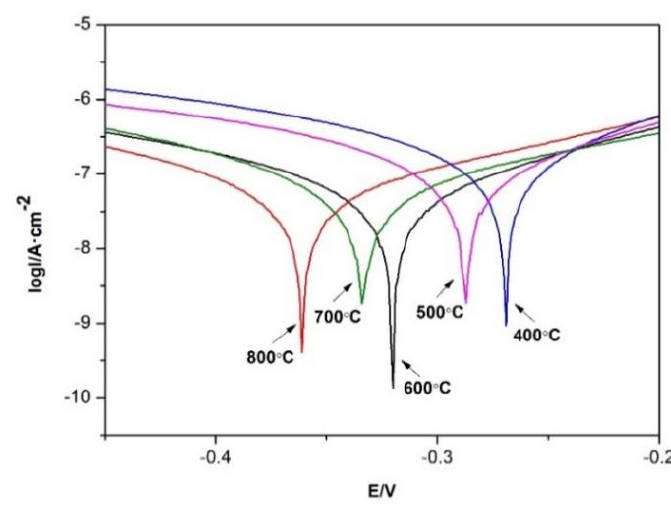
Figure 9. Tafel polarization curves of Ni/ZrO 2 gradient coatings after treatments at high temperatures.